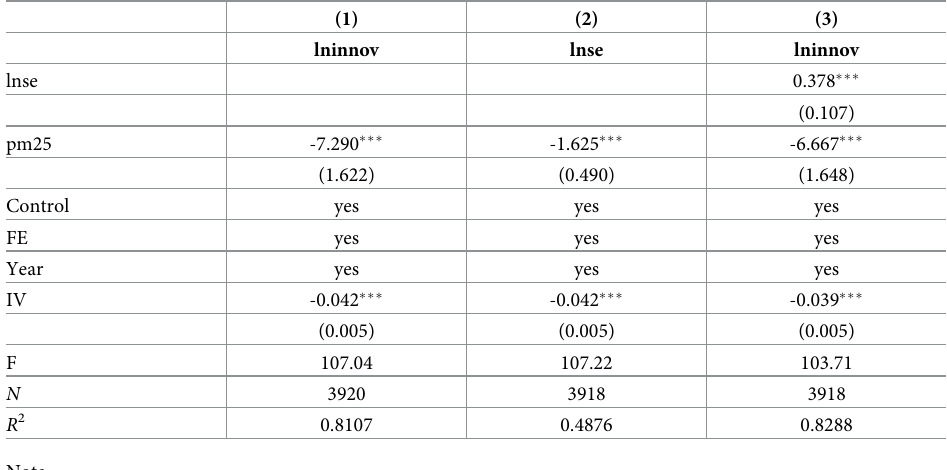
Table 9. Mechanism analysis of IV regression.